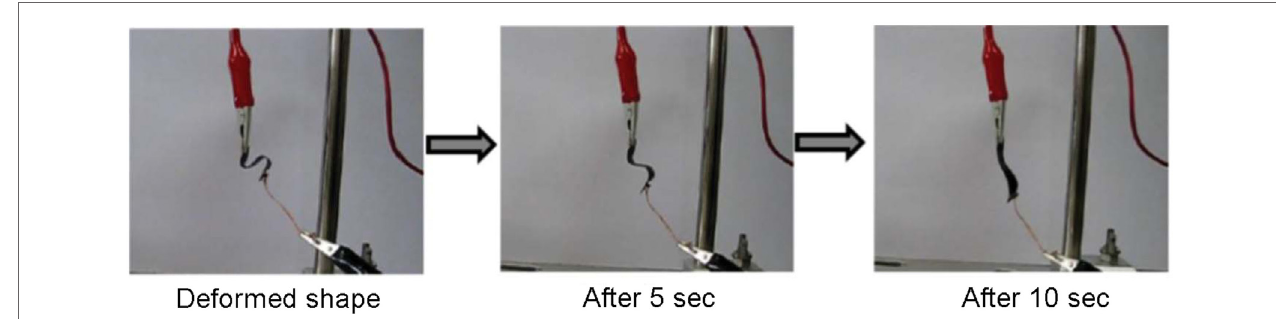
FiGURe 15 | Shape recovery behavior of graphene-cross linked PU composites, for a temporary helix shape (left) to a permanent shape when applying a constant voltage of 50 v . Reproduced with permission from Rana et al. (2013). Copyright 2013, Royal Society of